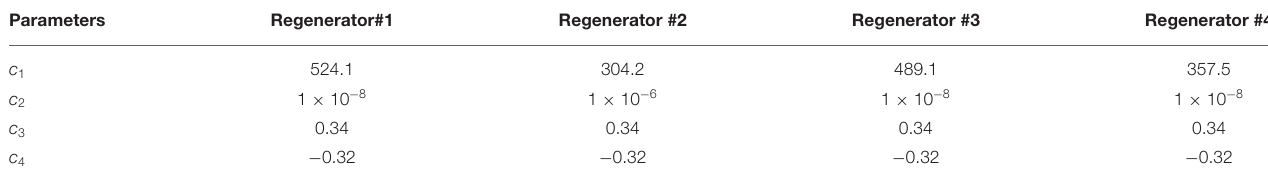
TABLE 2 | The values of the correlation parameters by fitting program, c 3 and c 4 of regenerators #1 to #3 are treated as the same as the values in regenerator #4, because the deviations between the modeling and experiments are small. Parameters